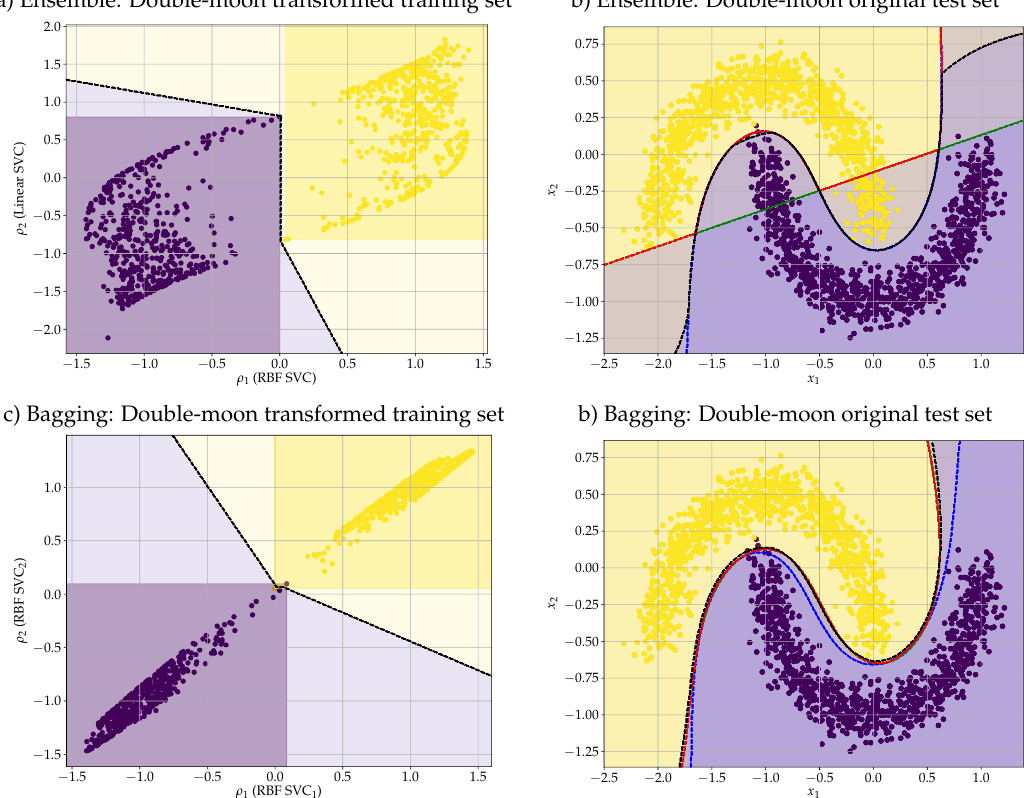
Figure 4. Performance of the ensemble r-DEP classifier on double-moon datasets described on Example 7. ( a ) and ( c ) show the scatter plot of transformed training data, the regions D ( w ) and E ( m ) , and the decision boundary of the DEP classifier. ( b ) and ( d ) depict the scatter plot of the original test data and the decision boundary of r-DEP (black) and other binary